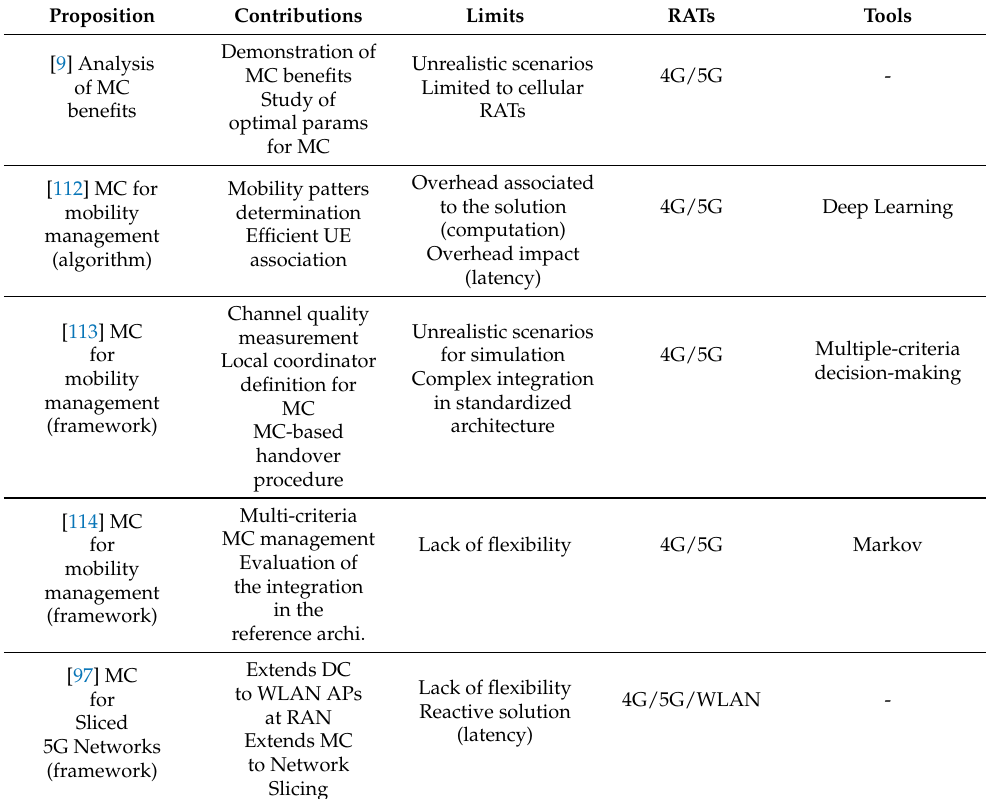
Table 6. Comparison of existing solutions for improving mobility